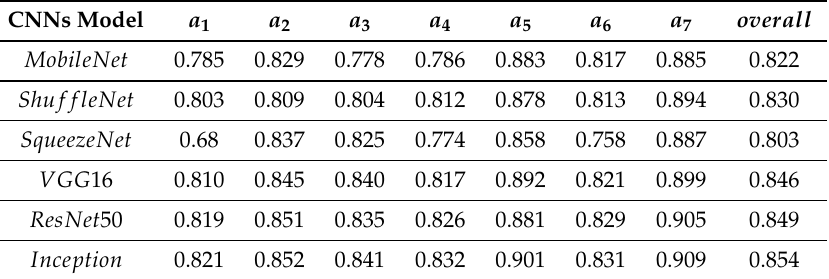
Table 5. Compressed model vs. heavy